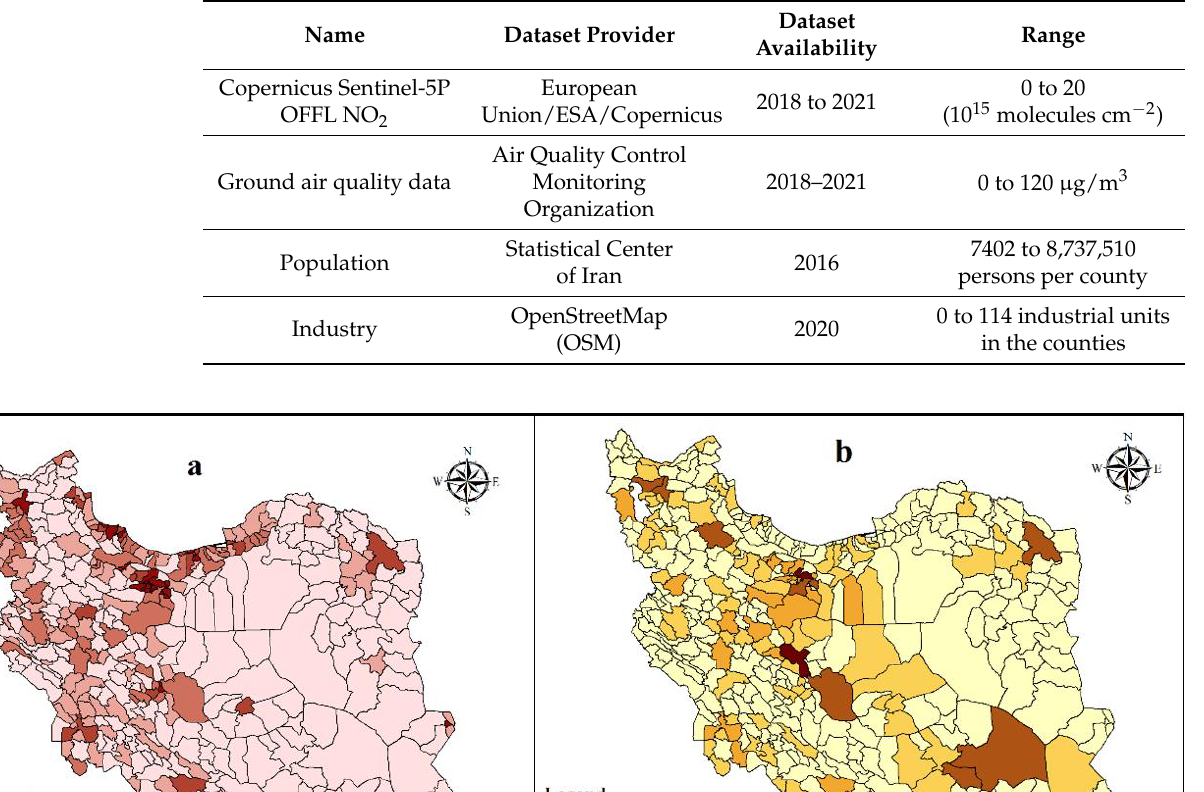
Table 1. Description of datasets included in the study.